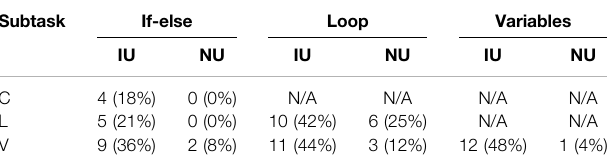
TABLE2| Errorclassi fi cationinthepick-and-placetask(improperuse,IU;nouse, NU) per programming statement for the conditional (C), loop (L), and variables (V)